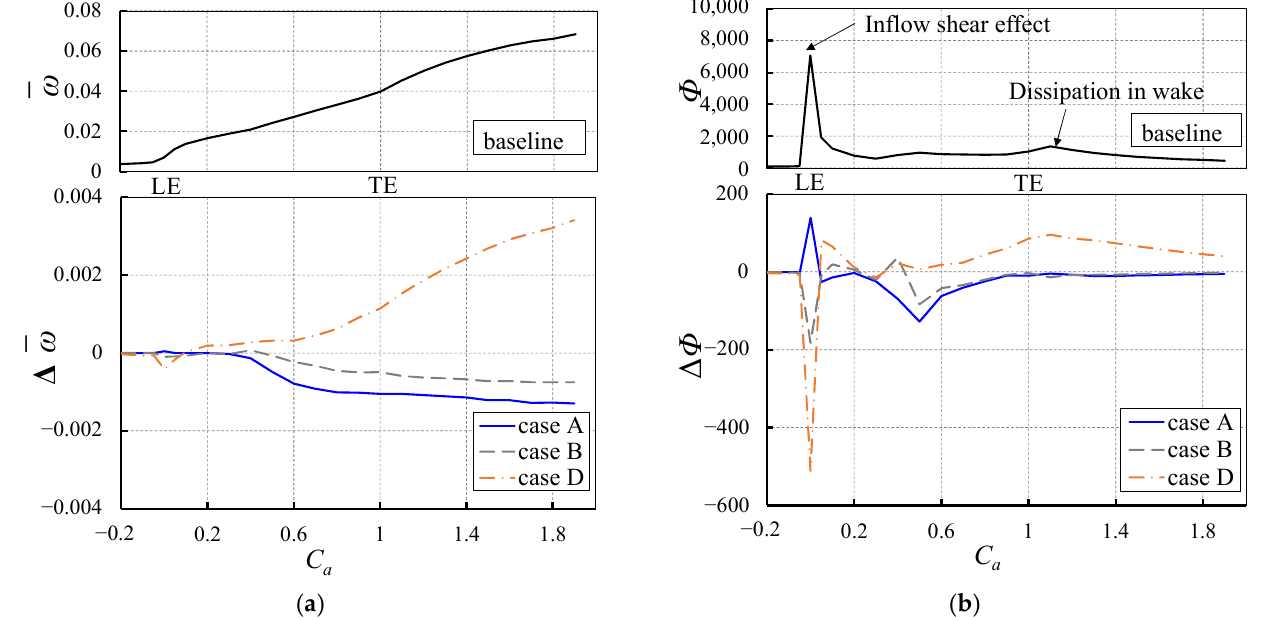
Figure 13. Development of loss in the passage at the design point. ( a ) Development of mass-flow- rate-weighted ω ; ( b ) development of area-averaged Φ .